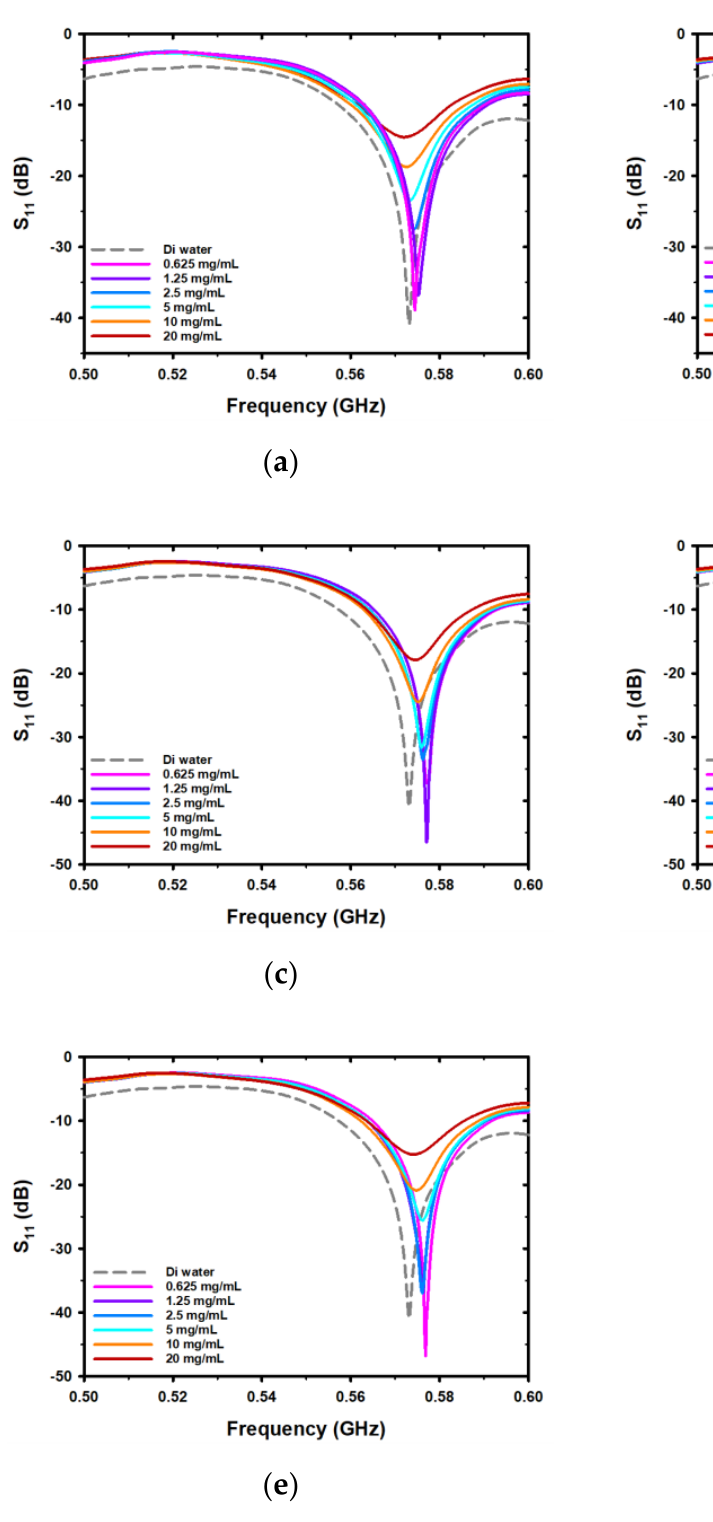
Figure 4. The reflection coefficient spectra in the frequency range from 0.5 GHz to 0.6 GHz for the first resonance peak for different concentrations of (a) sodium chloride (NaCl), (b) potassium chloride (KCl), (c) magnesium chloride (MgCl2), (d) calcium chloride (CaCl2), and (e) sodium carbonate (Na2CO3).